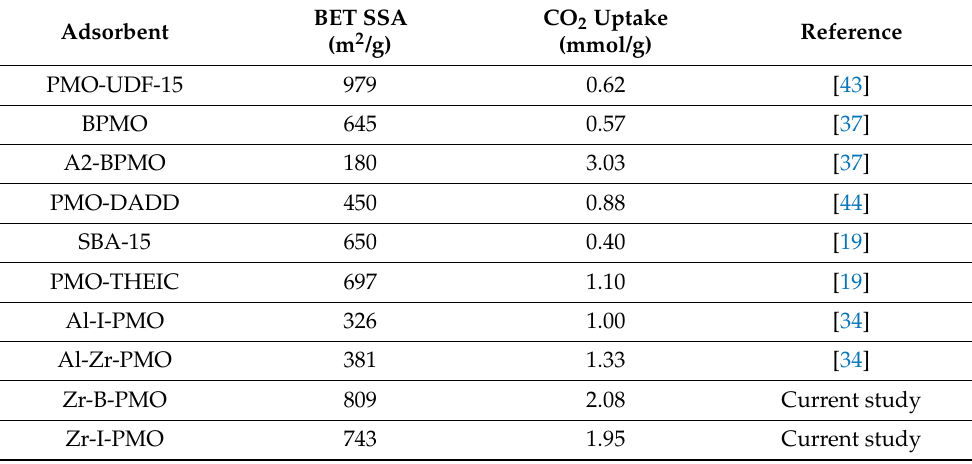
Figure 8. CO 2 ‐ sorption isotherms at 25 °C, measured on ( a ) Zr ‐ I10 ‐ TX and Zr # (as synthesized) and ( b ) Zr ‐ B10 ‐ TX and Zr # (as synthesized) samples. Table 2. Comparison of CO 2 -uptake values reported previously for various PMO sorbents at ambi- ent